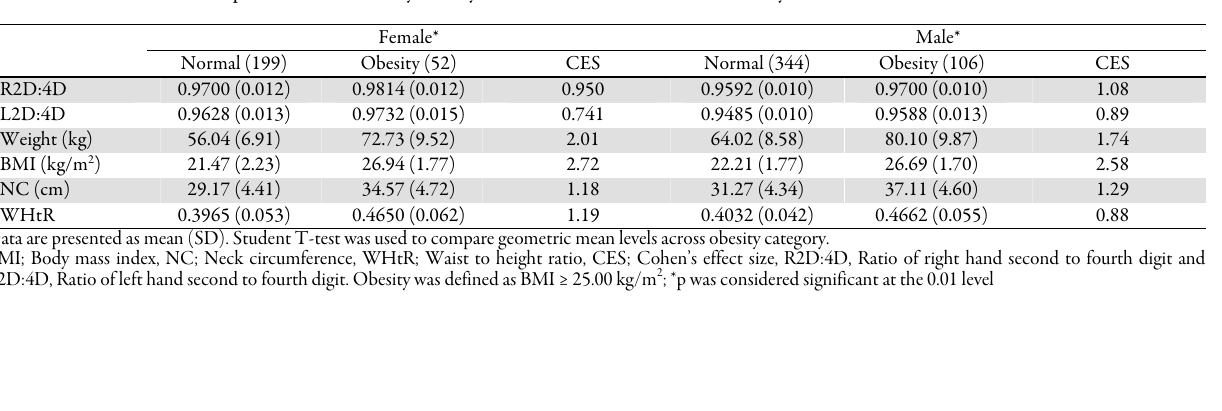
Table 2. Differences in anthropometrics stratified by obesity status in female and male under study